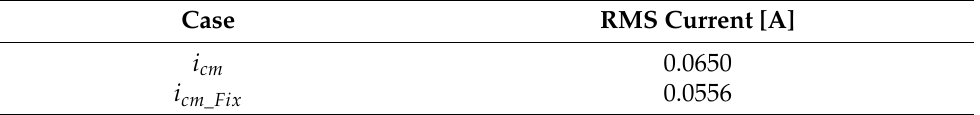
Figure 9. Comparison between i cm (blue line) and i cm _ Fix (dashed red line) with C oss _ Fix and C j _ Fix . Table 2. RMS values of i cm in case of variable and fixed value of parasitic